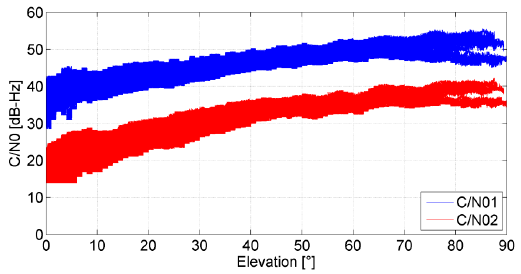
Figure 6. Refined reference C/N0 of C1 (C/N01) and P2 (C/N02) as a function of elevation.